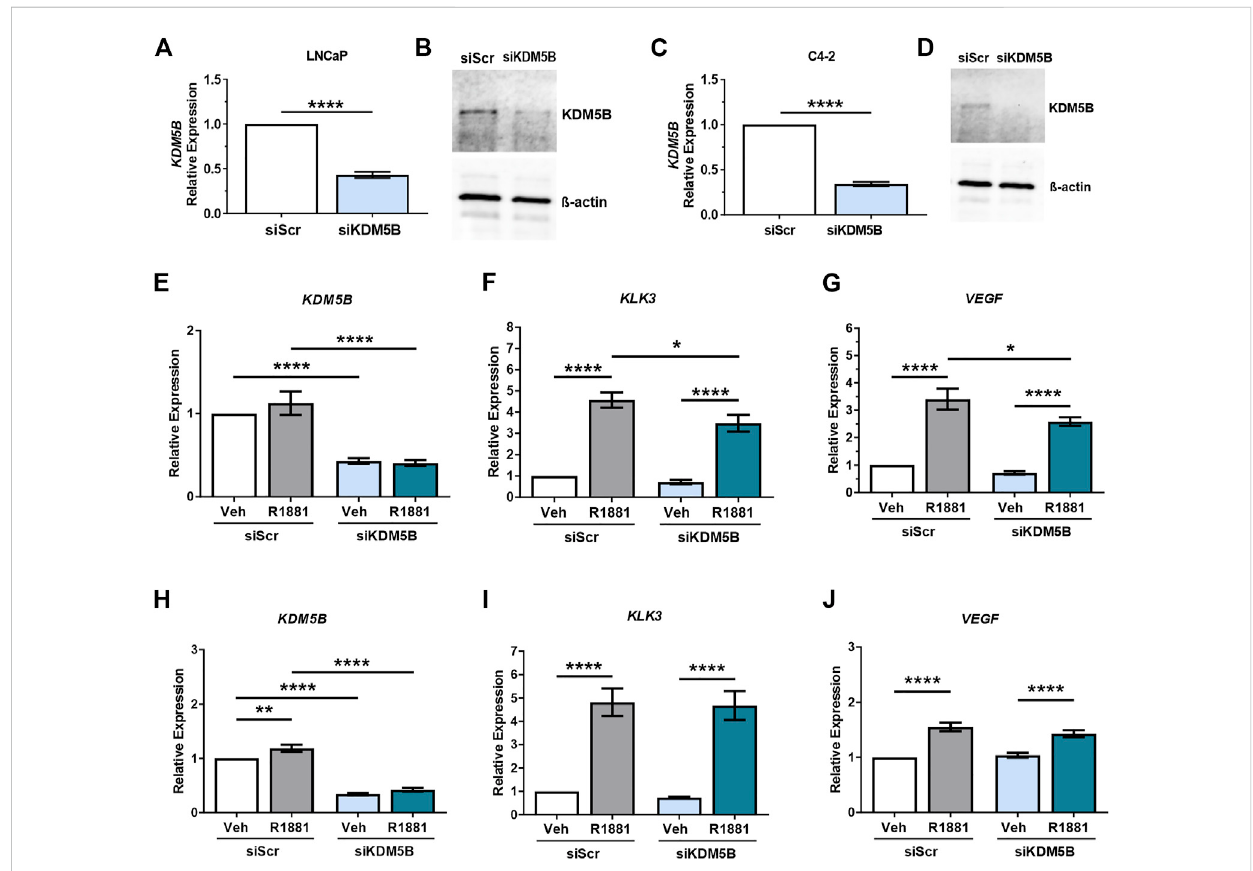
FIGURE 3 SiRNA-mediated knockdown of KDM5B in PCa cell lines LNCaP and C4-2. Con fi rmation of siRNA knockdown of KDM5B mRNA levels by RT-qPCR (A,C) and immunoblot for KDM5B protein levels. Beta-Actin was used as loading control (B,D) . Relative expression analysis on the effect of androgen treatment (1 nM R1881) and KDM5B knockdown on AR target genes, KLK3, and VEGF for LNCaP (E – G) and LNCaP:C4-2 (H – J) . Relative expression was calculatedagainstvehiclescrambledcontrolandnormalizationperformedusingGAPDH.Veh – Vehicle,R1881 – 1 nMR1881,siScr –